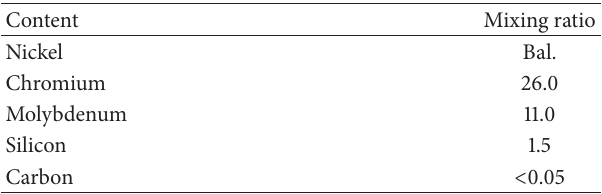
Table 1: Alloy chemical composition.